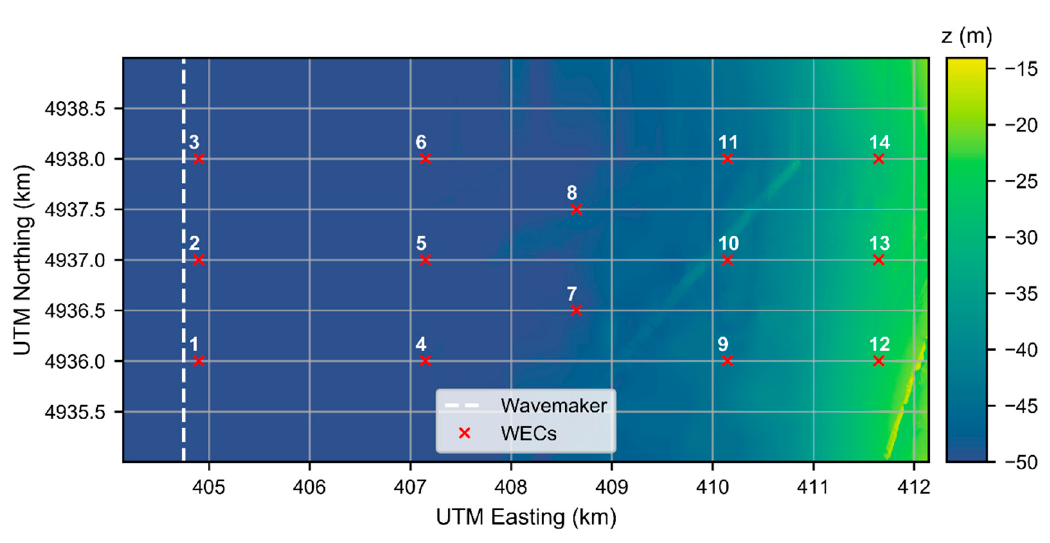
Figure 3. Wavemaker and WEC locations in the FUNWAVE domain, and colormap of PacWave South bathymetry. Table 1. Design of FUNWAVE model simulations.